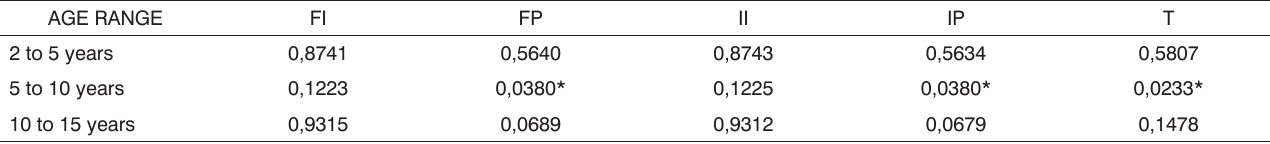
Table 6. Significance by variable in the three consistencies in the same age range (males) AGE RANGE